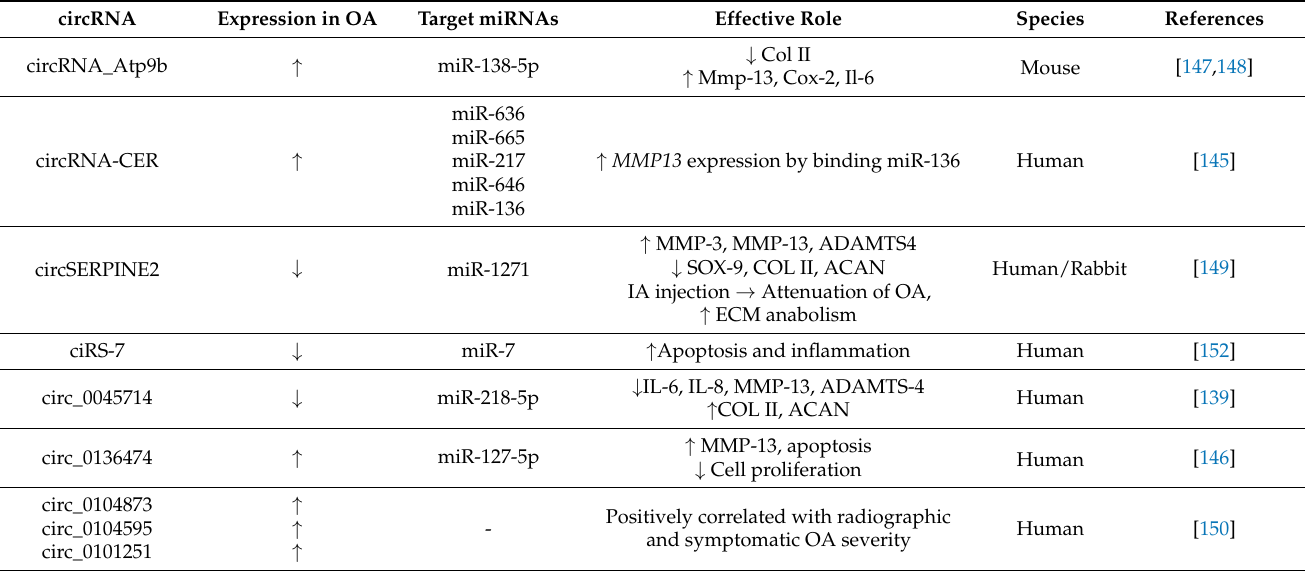
Table 2. Overview of the most relevant circRNAs in